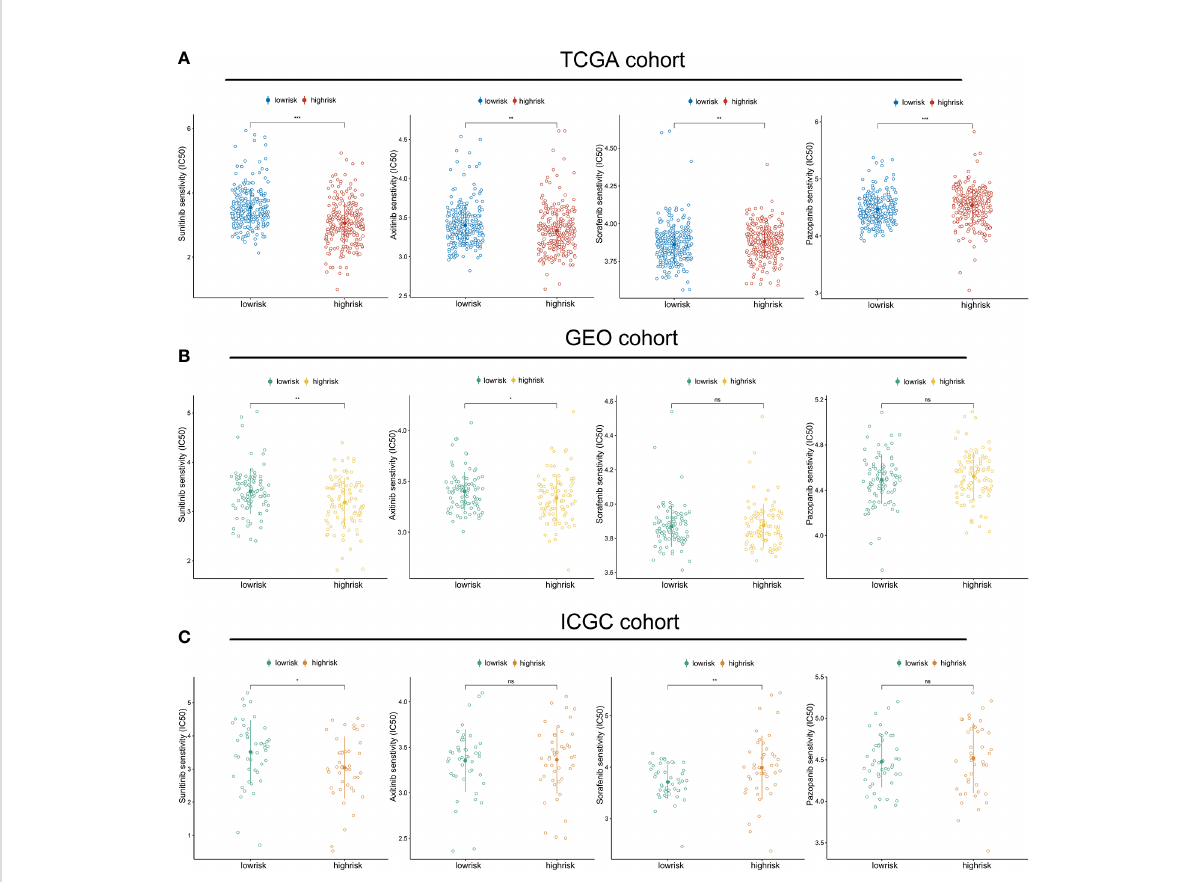
FIGURE 8 Riskscore predicts therapeutic bene fi ts of targeted therapies: The estimated IC50 values of sunitinib, axitinib, sorafenib and pazopanib in the TGCA cohort (A) , GEO cohort (B) , and ICGC cohort (C) . (*p < 0.05, **p < 0.01, ***p < 0.001). ns, no signi fi